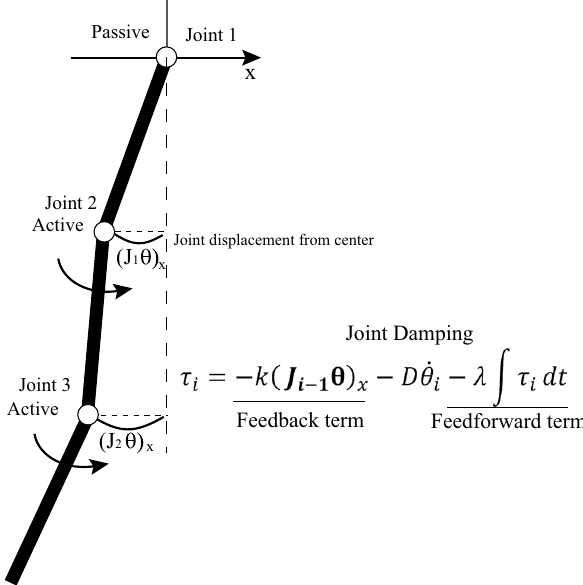
Figure 4. Synergetic learning control method for keeping limit-cycle